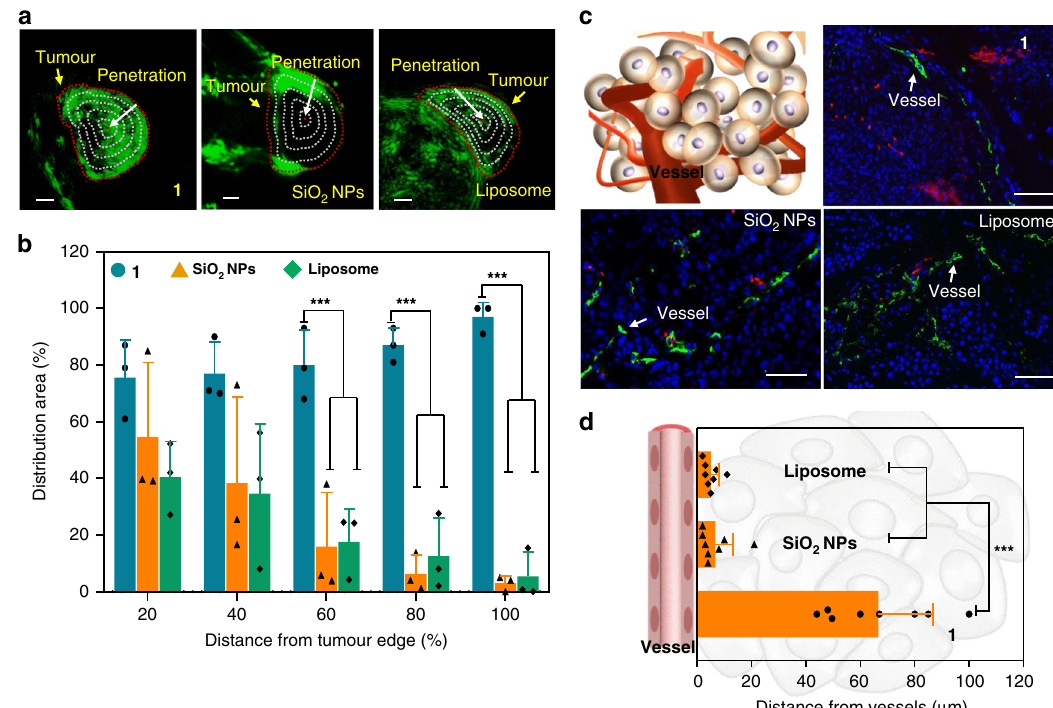
Fig. 5 Tumour penetrations of TCASS. a 3D reconstruction PA images of tumour-bearing mice injected with molecule 1, SiO 2 nanoparticles (SiO 2 NPs) and liposome labelled by Cy. The degrees of penetration into the tumour were calculated. To better illustrate the penetration extent of molecule 1, SiO 2 nanoparticles (SiO 2 NPs) and liposome labelled by Cy, the tumour tissue was divided into fi ve parts with identical radius intervals, which indicated the trend from the tumour edge to the interior (the red dashed circles show the tumour margin, and the grey dashed circles show the normalized distance from the tumour edge). b Quanti fi cation of the PA signal intensity. The PA intensity in the intratumoural distribution area between neighbouring polygons was normalized by the corresponding area. Data are presented as the mean± s.d. ( n = 3). *** p < 0.001, p values were performed with one-way ANOVA followed by post hoc Tukey ’ s test for the indicated comparison. c Frozen se c tions of tumour removed after treatment with molecule 1, SiO 2 NPs and liposome labelled by Cy for 12h. The tumour cell nucleus and vessels were stained with DAPI and FITC-tagged CD31 antibody, respectively. d Quanti fi cation of the penetrative distance of molecule 1, SiO 2 NPs and liposome labelled by Cy from the tumour vessels. Data are presented as the mean ±s.d. ( n = 8). *** p < 0.001, p values were performed with one-way ANOVA followed by post hoc Tukey ’ s test for the indicated comparison. Scale bar: a 2mm; c 50 μ